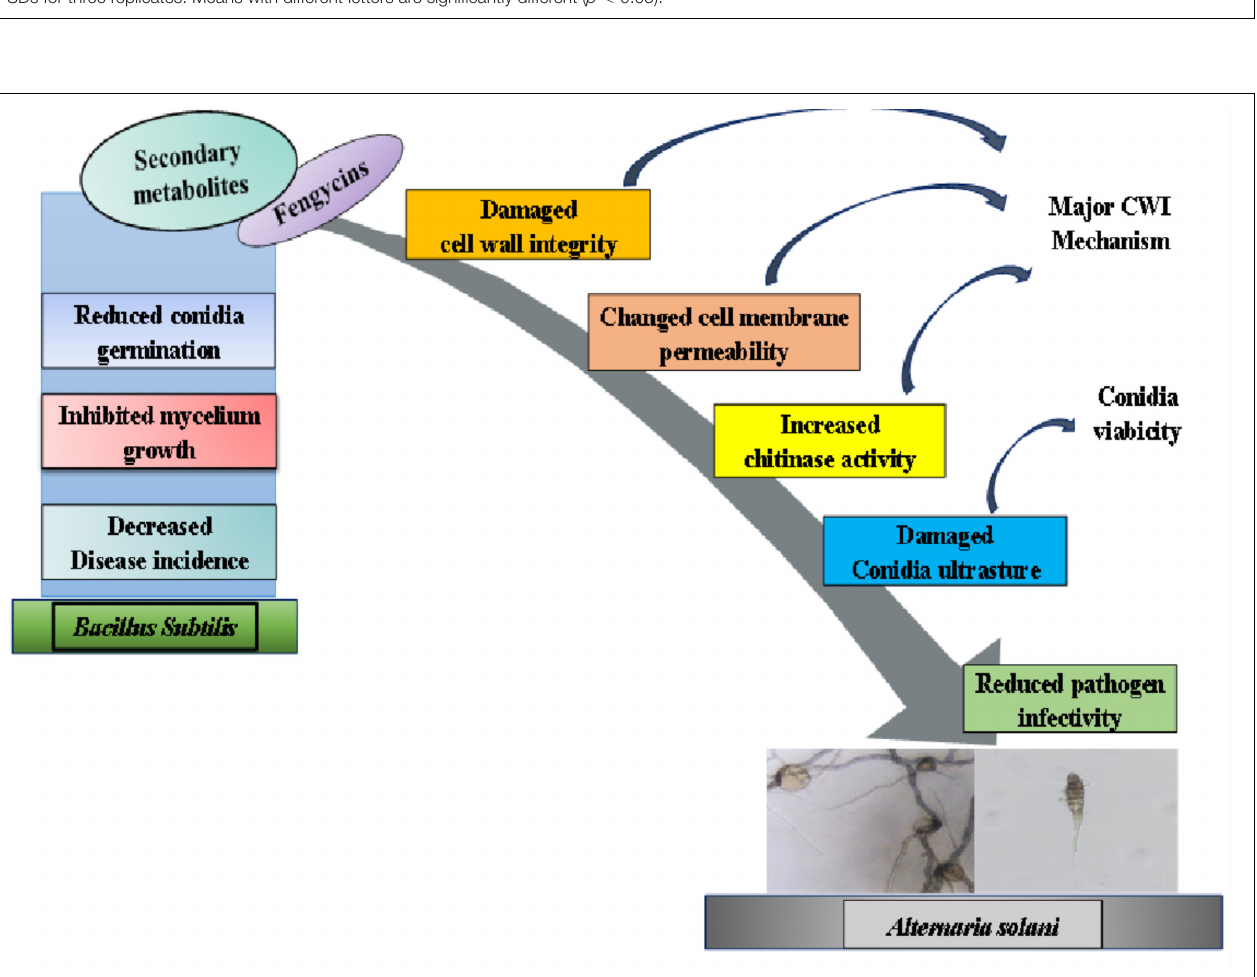
FIGURE 8 | A model for the mode of action of fengycins produced by ZD01 against A. solani . Fengycins produced by ZD01 mediate A. solani mycelial growth and conidial germination. Fengycins damage the cell wall integrity, change mycelial cell membrane permeability and alter conidial structures, which subsequently leads to the suppression of fungal growth, mycelial penetration, conidial vitality and germination. Therefore, A. solani fails to infect potato leaves.